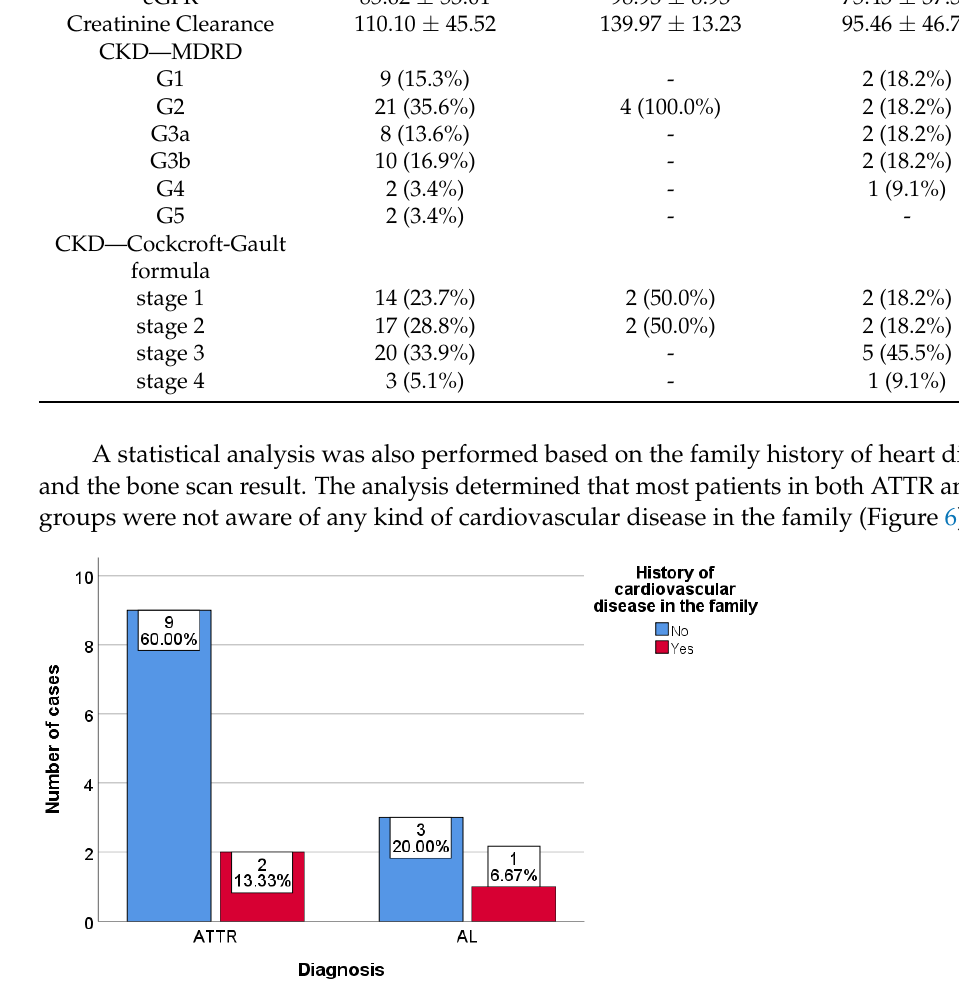
Figure 6. Correlation between the family history of cardiovascular diseases and the bone scan result.